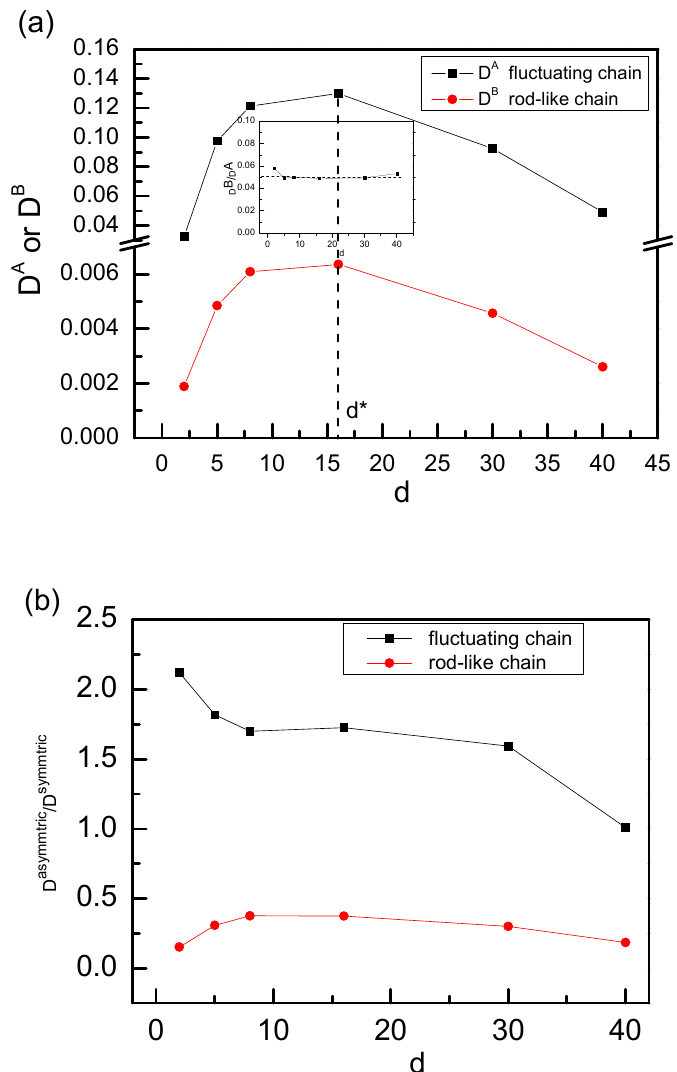
Figure 8. ( a ) Diffusion coefficient Dof ring chainsalongthe asymmetricaxial chainsfor ring chain A on fixed rod-like axial chain D A and ring chain B on fluctuating axial chain D B with different distances d between two asymmetricaxial chains. The inset figure shows the ratio of D B /D A as a function of d. ( b ) Ratio of D asymmtric /D symmtric for ring chain alongfluctuating axial chain or ring chain along the fixed rod-like chain in the asymmetric and symmetric axial chains cases with different distances d between two axial chains.